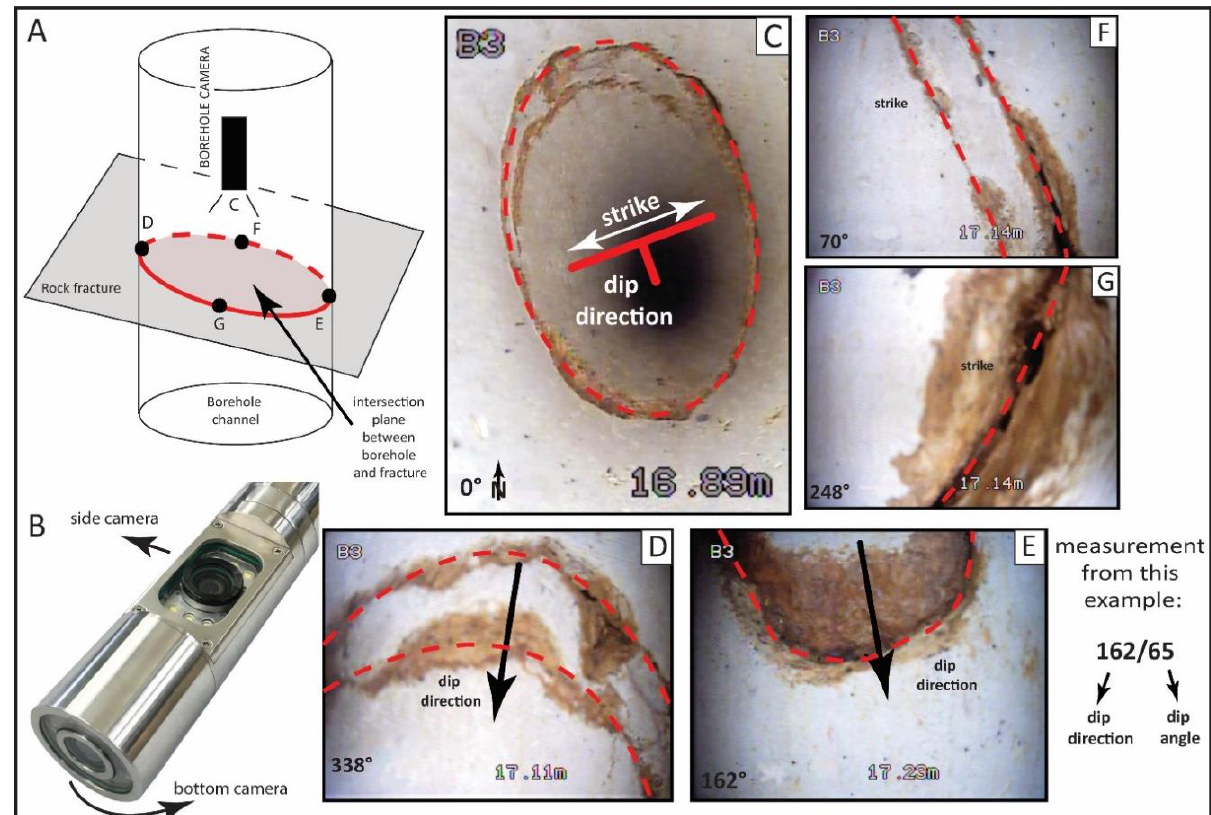
Figure 4. ( A ) Methodology of fracture orientation calculation. ( B ) Down camera view; ( C–G ) side camera view and fracture orientation determination.